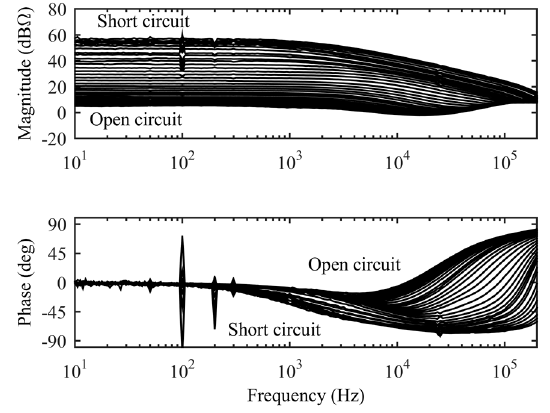
Figure 8. Measure output impedance of Raloss SR30-36 PV panel at the operating points from short-circuit to open-circuit condition.